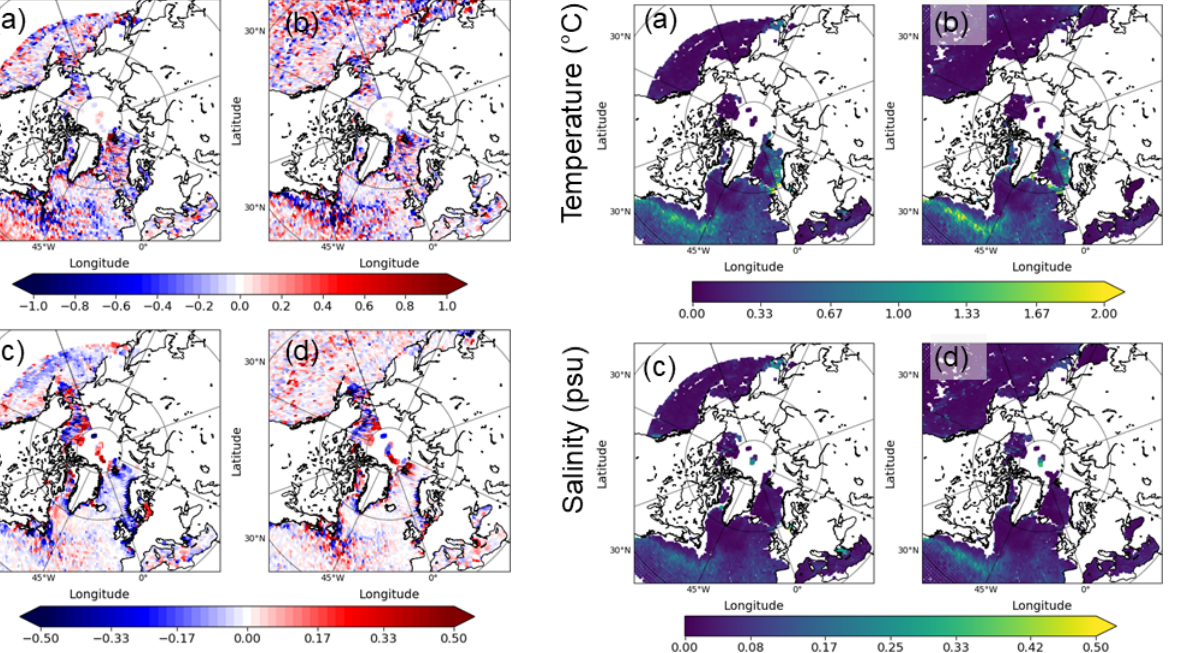
Figure 10. Innovation (observation–model) statistics of in situ tem- perature and salinity over the upper 500m depths for the period 1 January 2016 to 31 December 2018. The mean differences for temperature (a, b) and salinity (c, d) are shown for RIOPSv2 (a, c) and GIOPSv3 (b, d) .